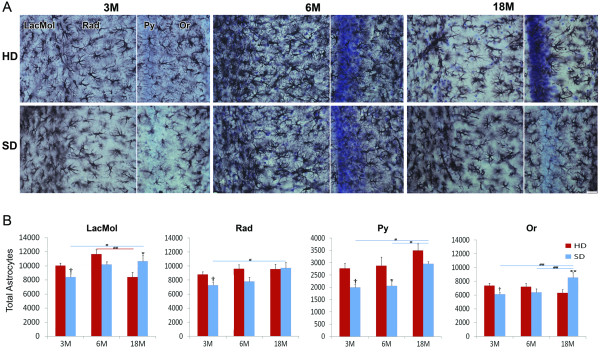
Laminar distribution and graphic representations of quantitative data of astrocytes in the CA1 hippocampal field. (A): Photomicrographs of CA1 layers in hippocampal sections from 3-, 6- and 18-month-old SD and HD mice. These sections were representative of mice that had astrocyte levels that were close to the mean values for each group. (B): The mean number and standard errors (s.e.m.) of stereological estimates of the total number of astrocytes for each CA1 layer in mice of the indicated age. (*) = Statistically significant differences (two tailed t-test; p < 0.05) between HD and SD age-matched mice. (#) = Statistically significant differences between SD and HD mice of different ages. LacMol. = stratum lacunosum-moleculare; Rad = stratum radiatum; Py = stratum pyramidale; Or = stratum oriens; HD = hard diet; SD = soft diet; 3 M, 6 M and 18 M indicate 3-month-old, 6-month-old and 18-month-old mice, respectively. Scale bar = 25 μm